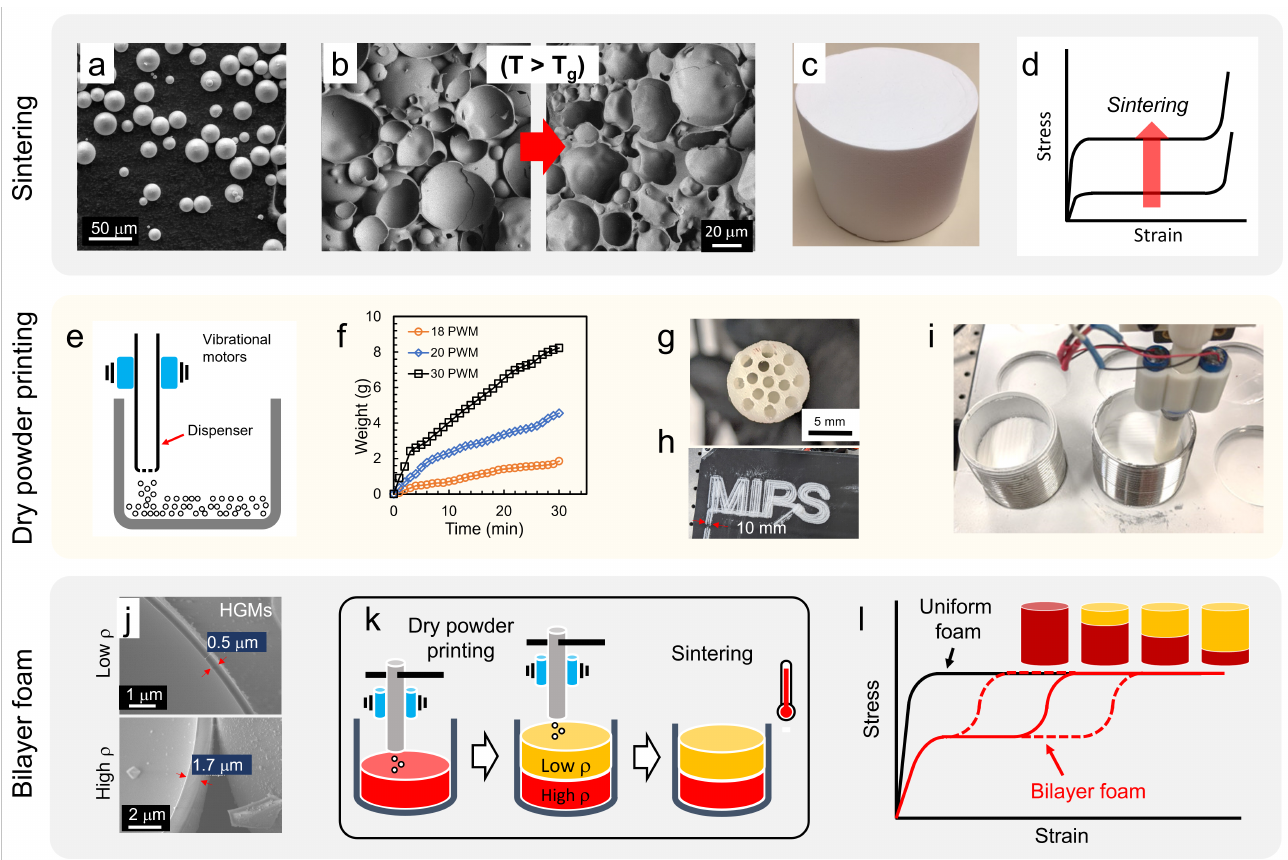
Figure 1. ( a ) SEM micrograph of hollow glass microspheres (HGM). ( b ) SEM micrographs of the amorphous glass foam microstructures for different durations thermal processing showing different levels of sintering. ( c ) Photograph of a sintered 4 inch diameter glass foam ( d ) Qualitative depiction of the stress–strain characteristics of sintering of glass foams ( e ) Schematic depiction of dry powder printing. ( f ) Dispensing rate of HGMs with different PWM (pulsed width modulation) via weight measurement as a function of dispensing time. ( g ) Bottom view of dispenser ( h ) Dry printed HGMs into letter MIPS. ( i ) Image of dry printing process. ( j ) SEM images of low and high density hollow glass spheres with wall thickness. ( k ) Schematic depiction of dry powder printing and bilayer glass foam sintering process ( l ) Qualitative depiction of the stress–strain characteristics of uniform (black) and bilayer foams (red). The dashed red curves represent the tunable loading profile obtained at different layer